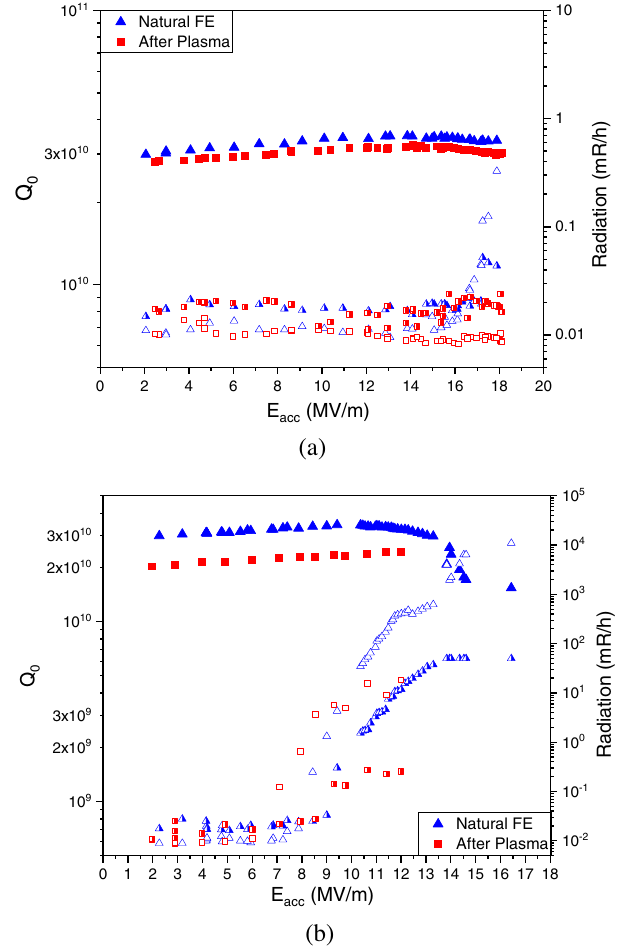
FIG. 6. Part (a) shows the results of the first naturally field emitting cavity: in blue is Q 0 and radiation level vs E performed before plasma processing. The x-ray onset is 16 MV = m before plasma processing; after plasma processing the FE was completely removed: the rf test measured after the treatment shows no x rays. Part (b) shows the rf tests of the second cavity. The test was stopped before quenching due to intense x rays. The red curves show the performance after plasma processing: no increase in performance has been registered after the cleaning. Solid symbols are used to plot the Q 0 vs E empty symbols for the radiation detected from the top detector, and half-filled symbols for the bottom radiation detector.